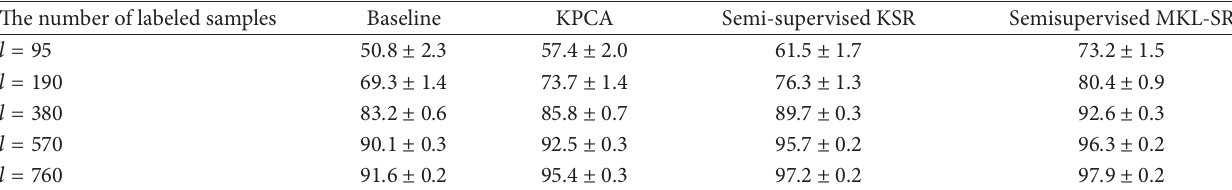
Figure 1: Performance of MKL-SR with respect to 𝛾/(1 + 𝛾) on PIE. (a) 𝑙 = 10 . (b) 𝑙 = 30 . Table 4: Recognition accuracy rates on Extended Yale B (mean ±